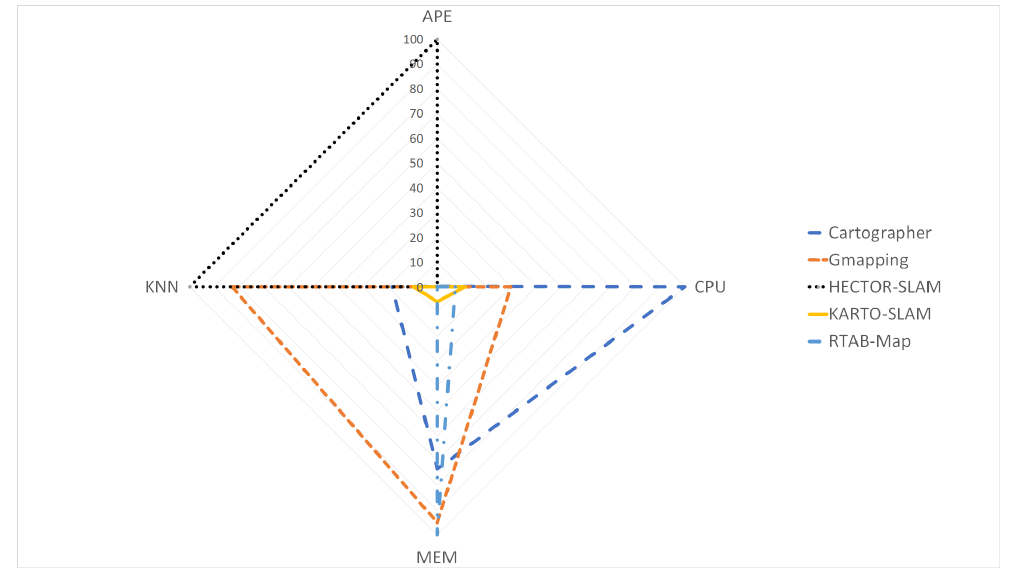
Figure 34. Radar plot with all the algorithms